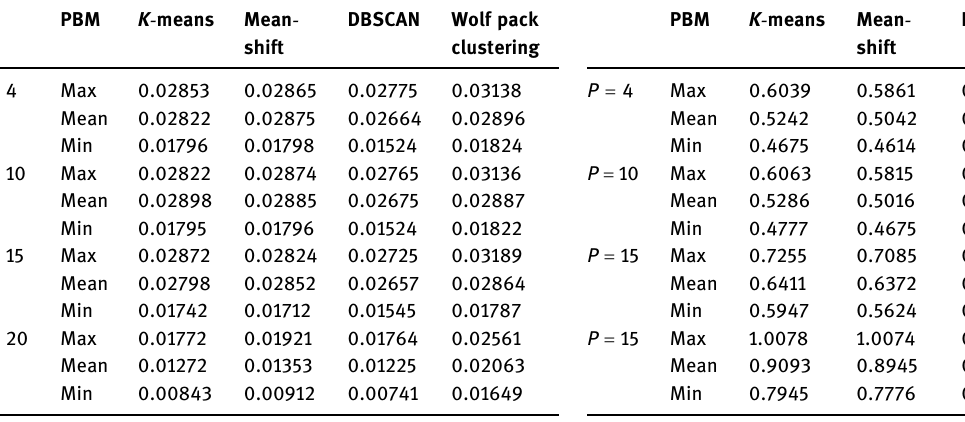
Table 2: PBM performance with di ff erent numbers of data attributes when N = 50,000